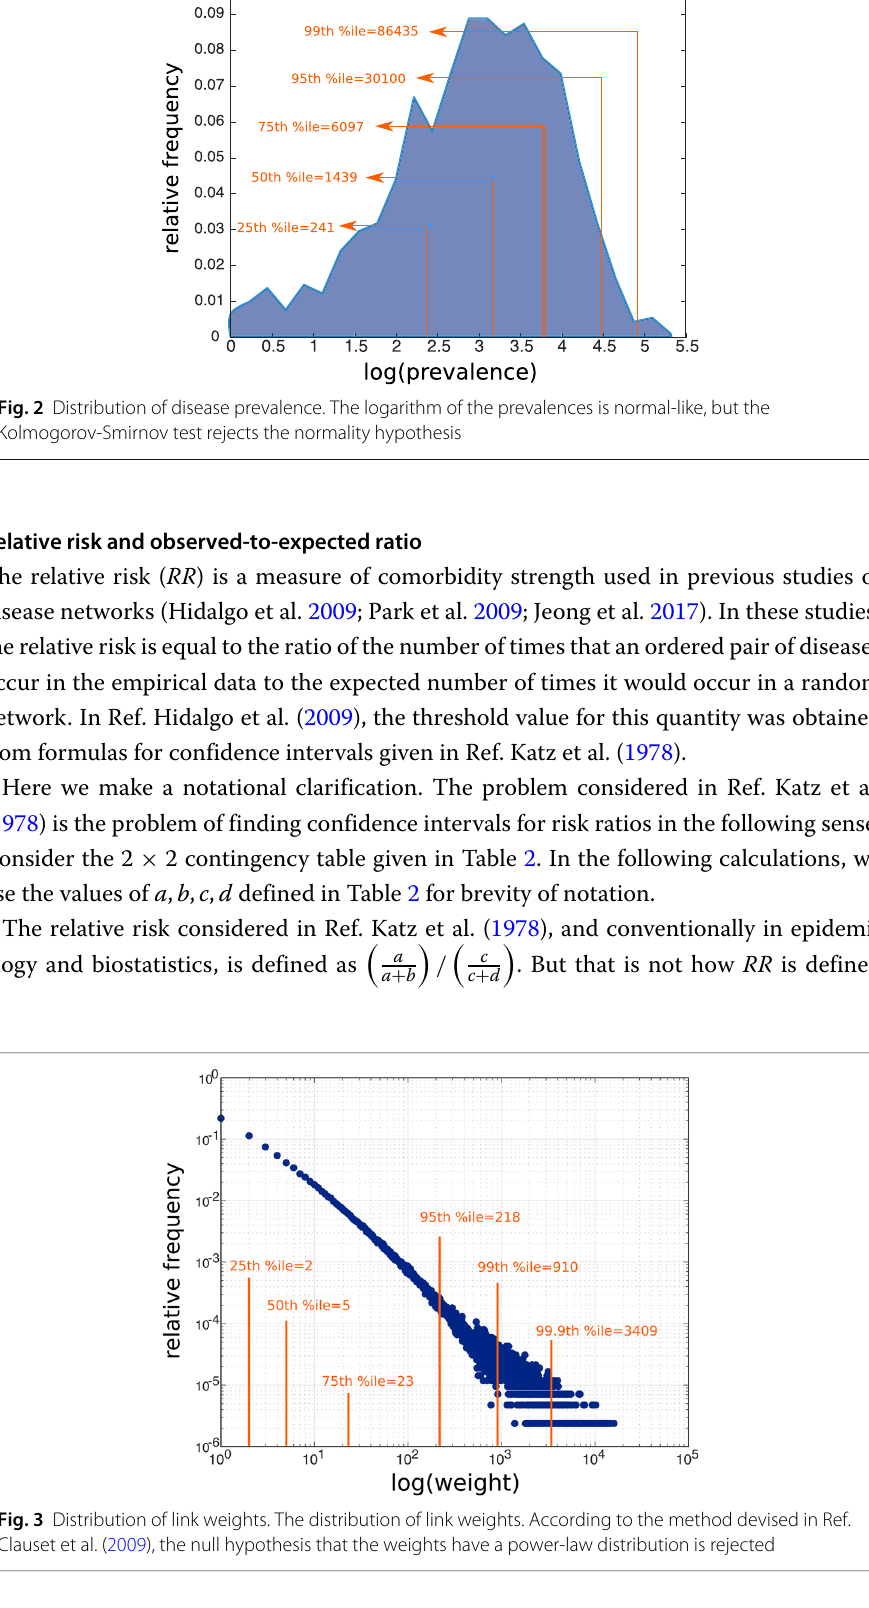
Relative risk and observed-to-expected ratio